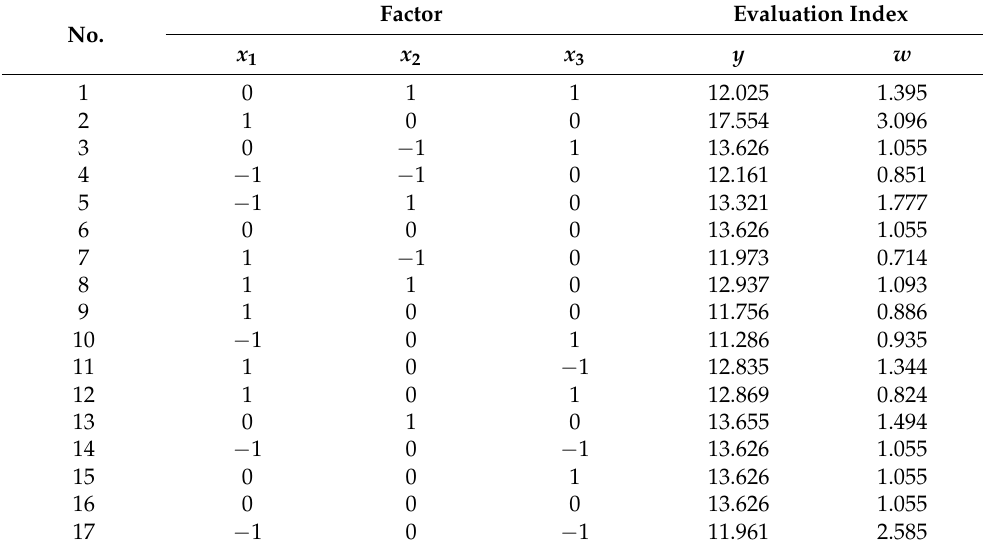
Table 2. Test scheme and